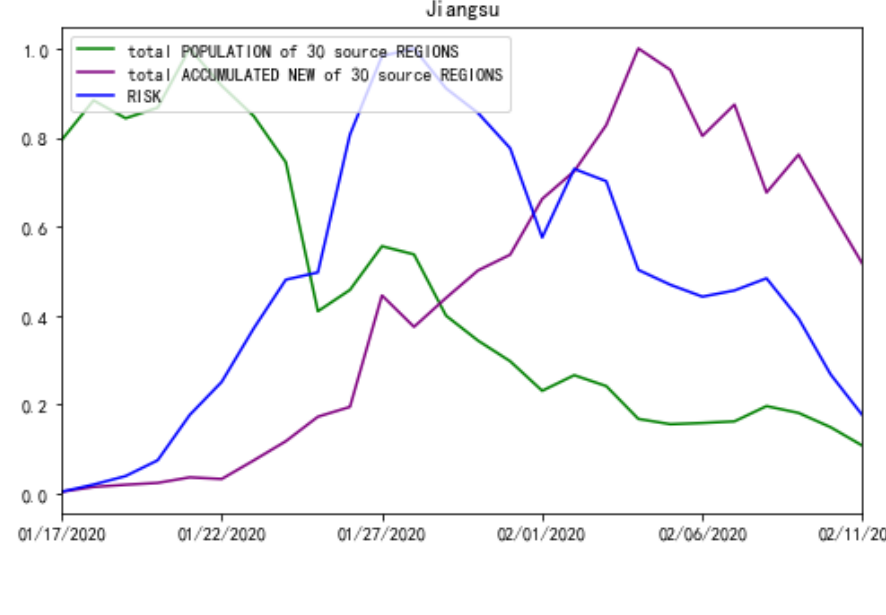
Figure 2. RISK of Jiangsu Province from January 17, 2020 to February 11,